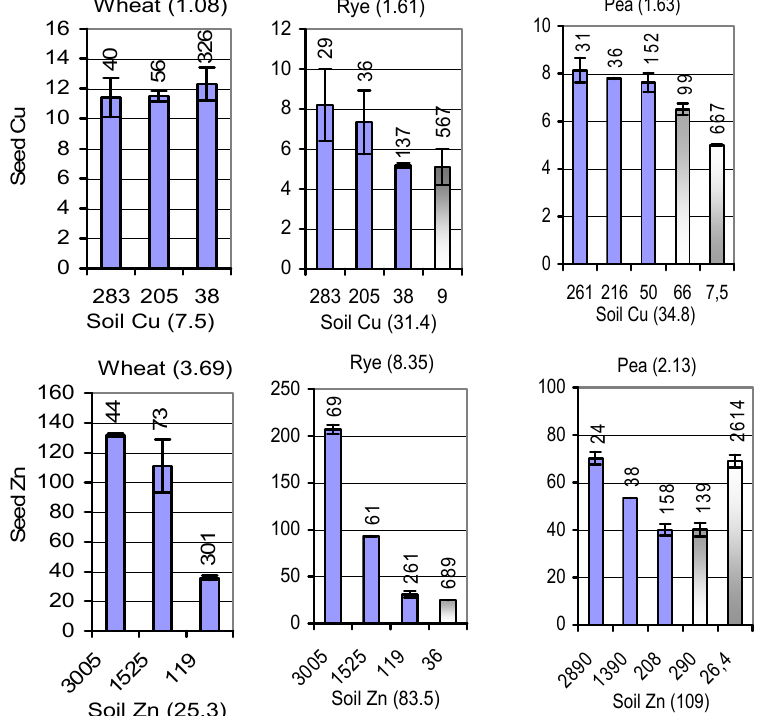
Figure 4. Concentration spans (factors in parentheses) in the CuZn stock (mg kg − 1 DW) of the soils diminish drastically in the seeds of wheat, rye, and pea due to proportionate up-regulations of the seed:soil transfer factors (values heading the columns × 10 − 3 ) on lower concentrated soils. Soils, left to right: Uranium gradient soils (3 × ) C org 3.5%–4%; soil C org 8.9%; alluvial sand C org 1.97%. Concentrations in CuZn represented by the bars are given in mg kg − 1 DW. Adapted from primary data of Gramss and Voigt [18,27].